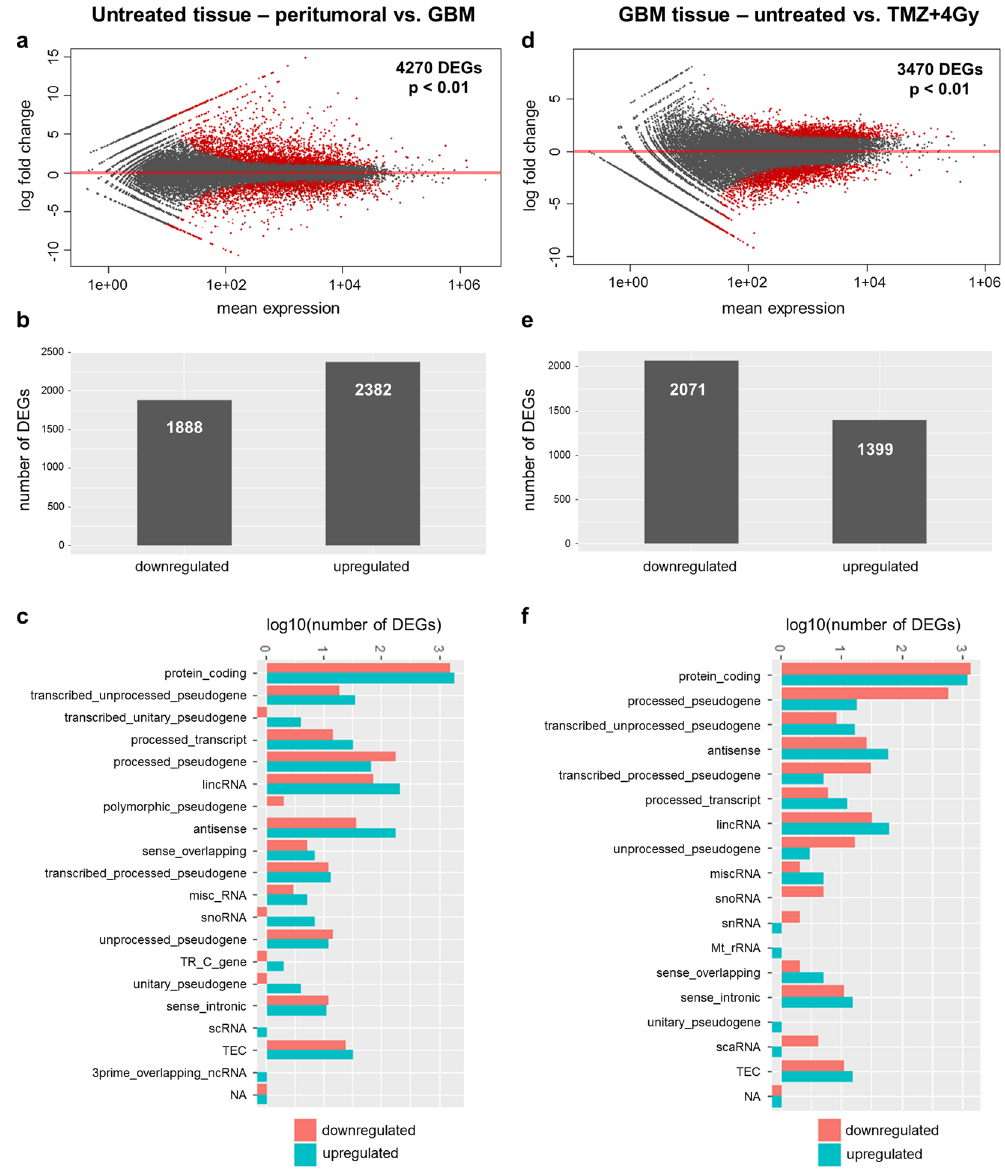
Figure 4. Differentially expressed genes (DEGs) between peritumoral brain and GBM tissue. Analysis of differentially expressed genes (DEGs) between untreated peritumoral brain tissue of zone III and GBM tissue samples of zone I ( a–c ) and between untreated and treated GBM samples ( d–f ). ( a,d ) Significantly regulated transcripts are indicated in red (p < 0.01). ( b,e ) Number of down- and upregulated genes in both comparisons. ( c,f ) Biotype of down- (red) and upregulated (blue) transcripts in both comparisons. TEC = to be experimentally confirmed, NA = not